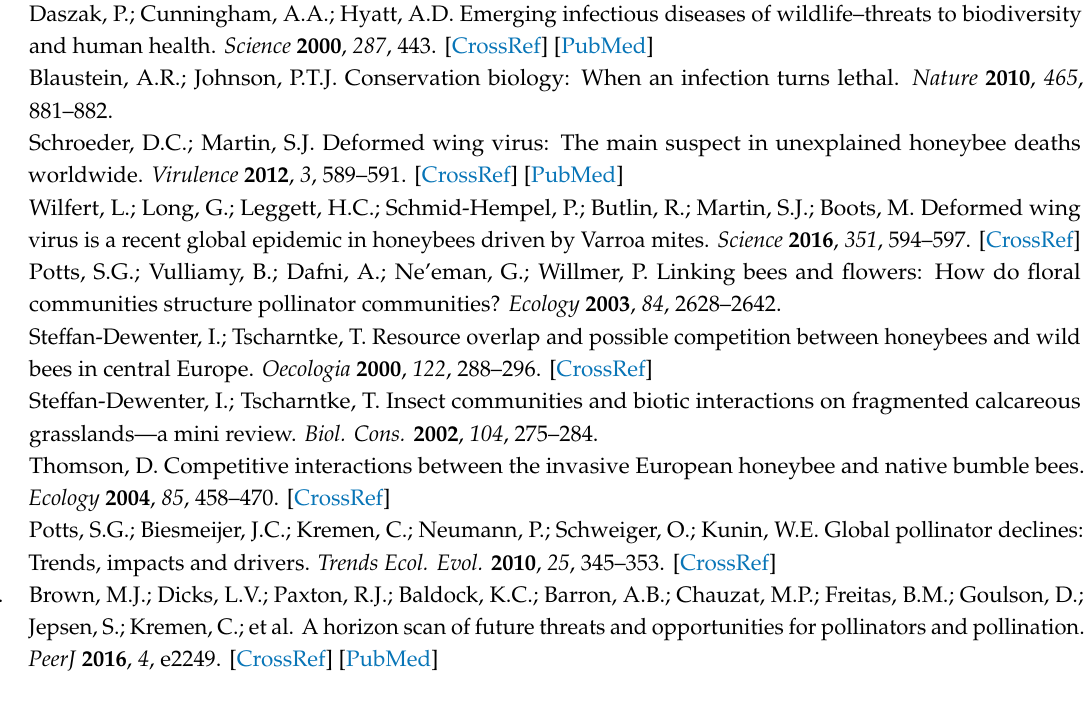
Figure S1: DWV genome coverage plots for individual samples created using Geneious. Read depths are shown on a log-10 scale and represent DWV-A (red), -B (blue), and -C(yellow) along the ~10.1 kb genomes. Figure S2: DWV alignments (MUSCLE) created using Geneious showing de novo assembled contigs from samples A_tum-5 and V_pens-8, which contain recombination breakpoints. (a) Contig A_tum-5-a aligned with DWV-A (NC_004830.2) and DWV-C (CEND01000001.1) reference genomes, (b) contig V_pen_8-b aligned with DWV-A (NC_004830.2) and DWV-B (AY251269.2), and (c) a second contig from sample V_pen_8; V_pen_8-t also aligned with DWV-A (NC_004830.2) and DWV-B (AY251269.2). All alignments show disagreements with the assembled contigs highlighted in black, and recombinant contigs are shaded red where they map most closely to DWV-A, blue to DWV-B, and green to DWV-C. Table S1: Samples used in this study. Sample names are given along with the site from which they were sampled, species name, and the symbol used to denote them in Figures 1 and 5. Table S2: DWV-A RdRp sequences originally from [4] and used in this study in the construction of the DWV-A phylogeny in Figure 5. Table S3: Viruses commonly found in bees used for BLAST analysis along with accession numbers. Table S4: Numbers of reads mapping to DWV types A, B, and C using Blast top hit analysis for each sample, along with total numbers of reads passing QC